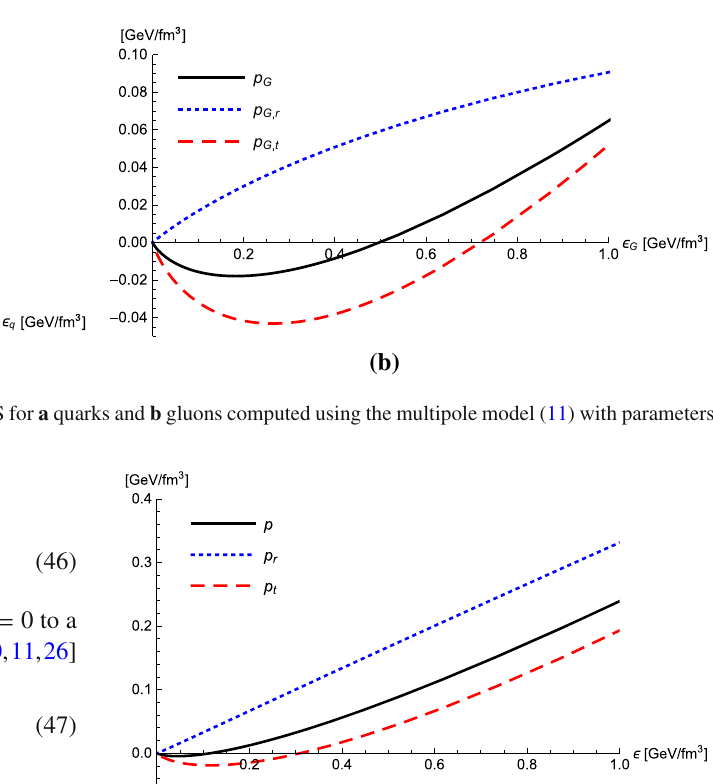
Fig. 9 Radial p r (ε) , tangential p t (ε) , and isotropic p (ε) EoS of the nucleoncomputedusingthemultipolemodel(11)withparametersgiven in Table 1, see Eqs. (34)–(37) for